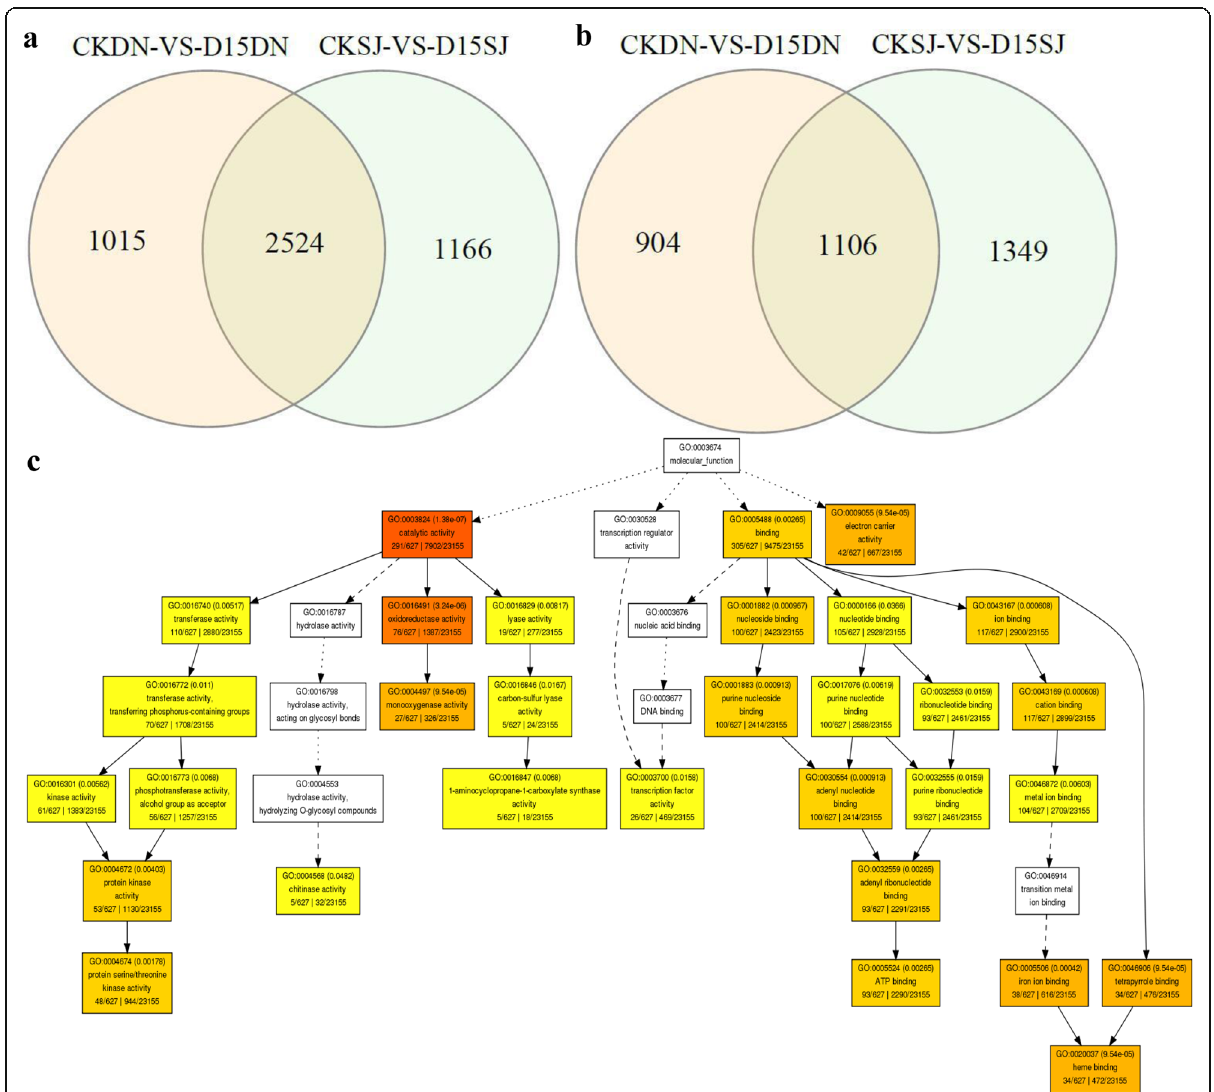
Fig. 4 Comparative transcriptome analysis of the two cultivars revealed cold tolerance mechanisms. a , Venn diagram of the downregulated differentially expressed genes in Dongnong428 (DN) under control (CKDN) vs. DN under low-T w (D15DN) and Songjing10 (SJ) under CKSJ vs. D15SJ. b , Venn diagram of the upregulated differentially expressed genes in CKDN vs. D15DN and CKSJ vs. D15SJ. c, GO enrichment analysis of the specific CKSJ vs. D15SJ differentially expressed